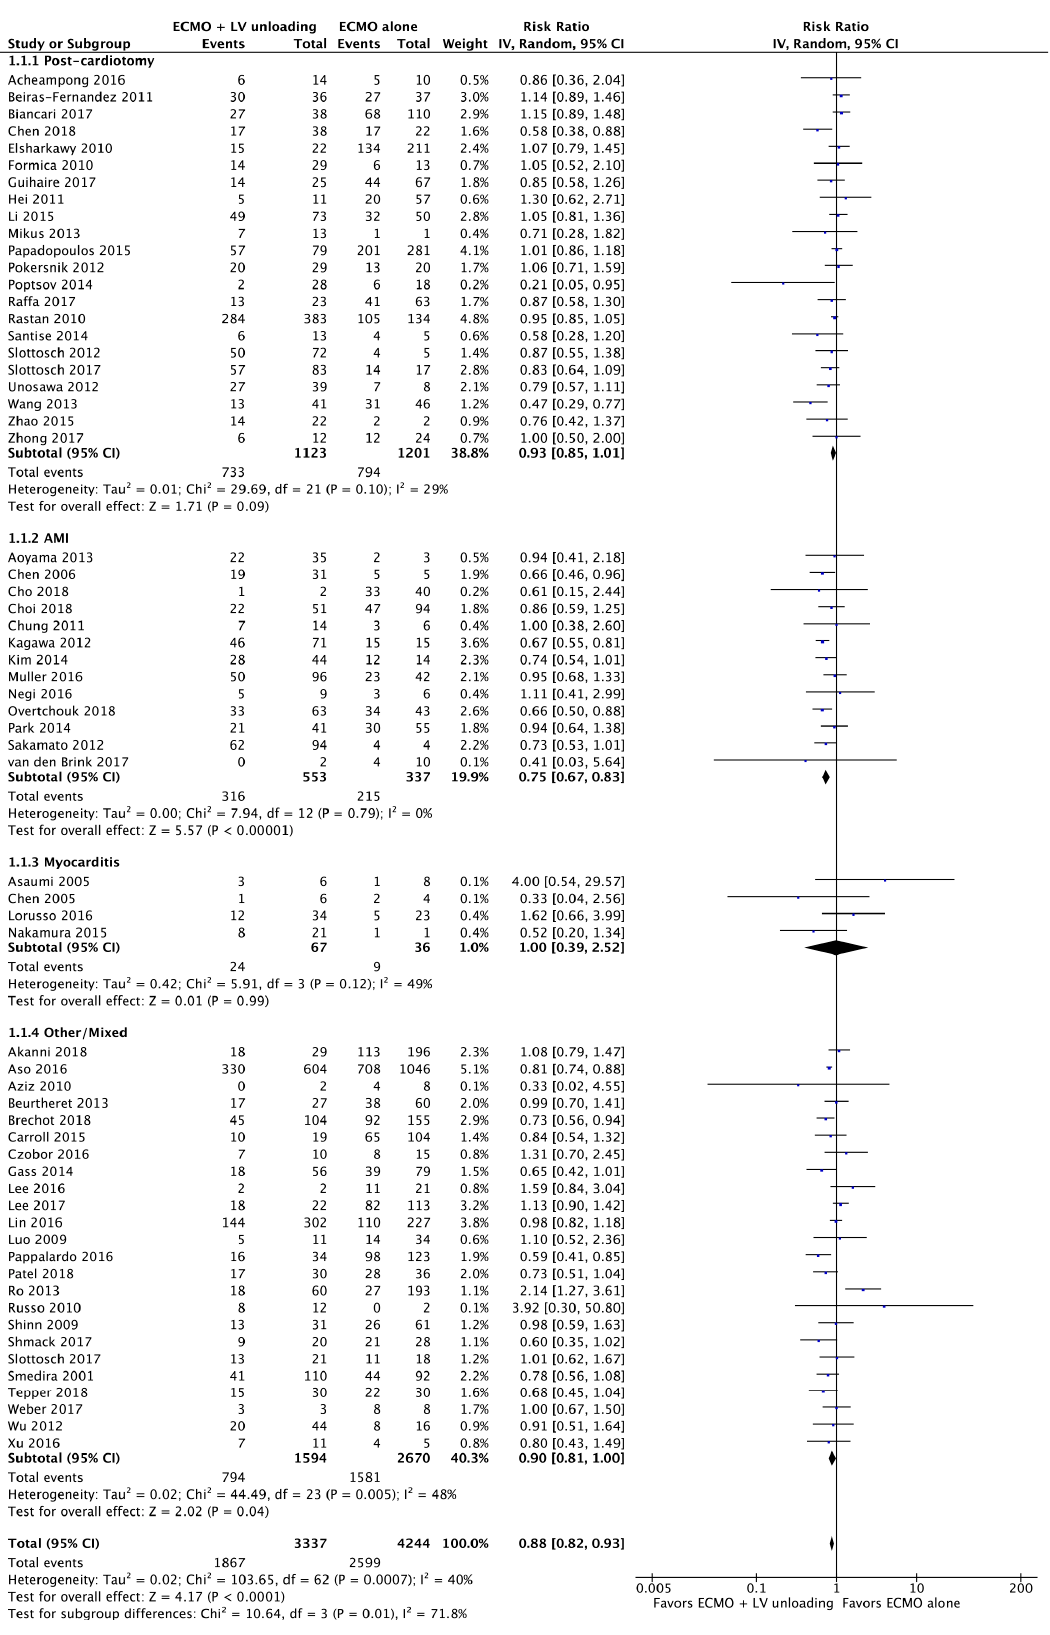
Figure 3. All-cause in-hospital mortality rate for patients receiving extracorporeal membrane oxygenation (ECMO) + left ventricular (LV) unloading versus ECMO alone treatment according to cardiogenic shock